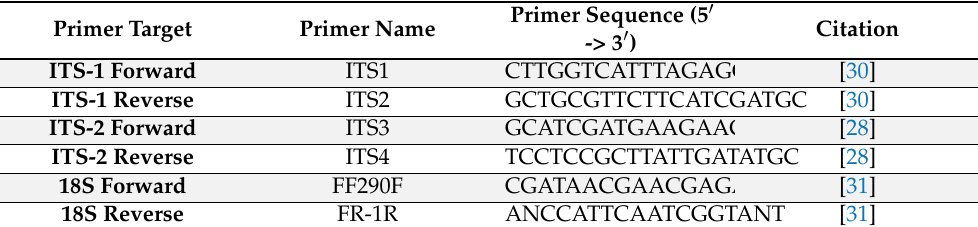
Table 1. Fungal-specific